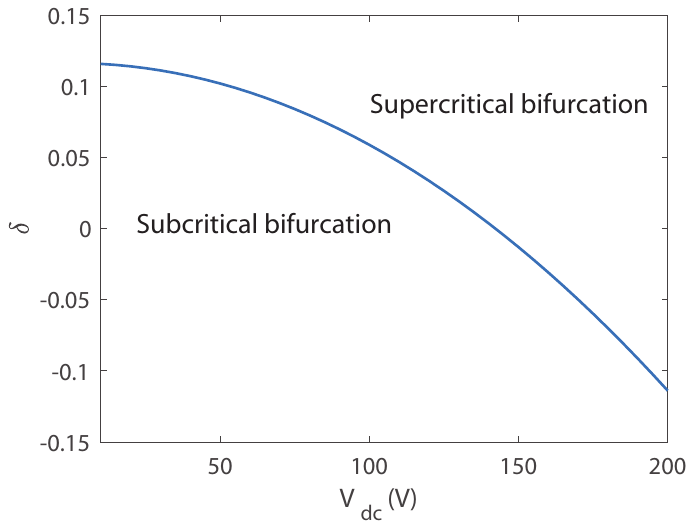
Figure 5. Variation of the bifurcation behavior versus δ and V dc .